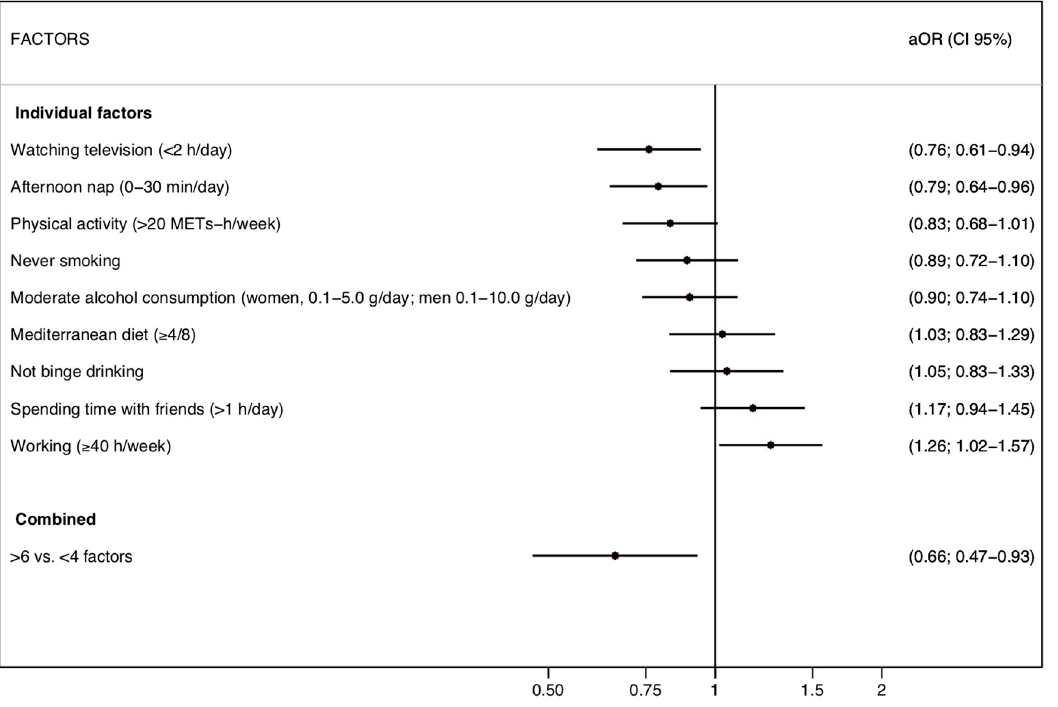
Figure 2. Risk of metabolic syndrome for each factor of the Healthy Lifestyle Score (the SUN cohort); aOR: Adjusted odds ratio; CI: Confidence interval.